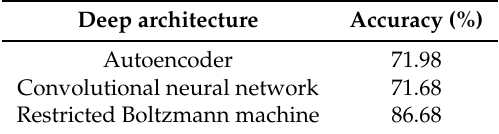
Table 4. Average classification results using the amino acid hydrophobicity-related index (AAhydro) set.